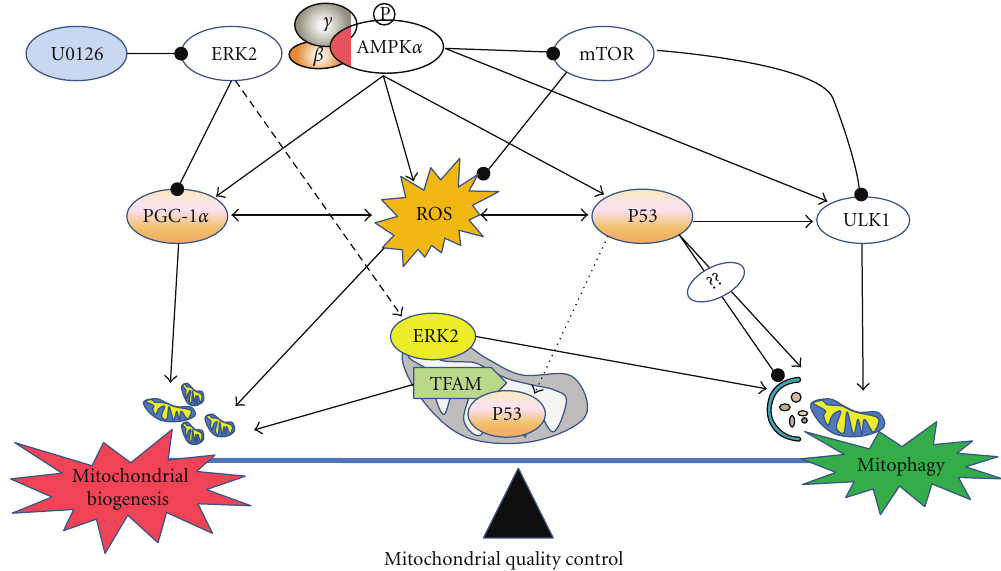
Figure 1: A well-controlled regulation of mitochondrial quality via mitochondrial biogenesis and mitophagy. Mitophagy, in conjunction with mitochondrial biogenesis, regulates the changes in mitochondrial number that are required to meet metabolic demand. Activated AMPK acutely triggers ULK1-dependent mitophagy and simultaneously triggers the biogenesis of new mitochondria via e ff ects on PGC- 1 α -dependent transcription. Conversely, mTOR represses mitochondrial biogenesis and ULK1-dependent mitophagy when nutrients are plentiful. These dual processes controlled by AMPK and mTOR determine the net e ff ect of replacing defective mitochondria with new functional mitochondria. AMPK: AMP-activated protein kinase; mTOR: mammalian target of rapamycin; PGC-1 α : PPARgamma coactivator 1-alpha; ULK1: the mammalian Atg1 homologs, uncoordinated family member (unc)-51: like kinase 1; ERK2: the extracellular signal- regulated protein kinase 2; U0126: ERK